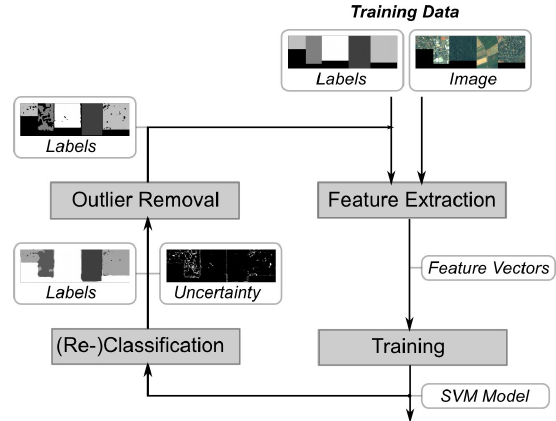
Figure 2: Training data refinement scheme. Larger images of